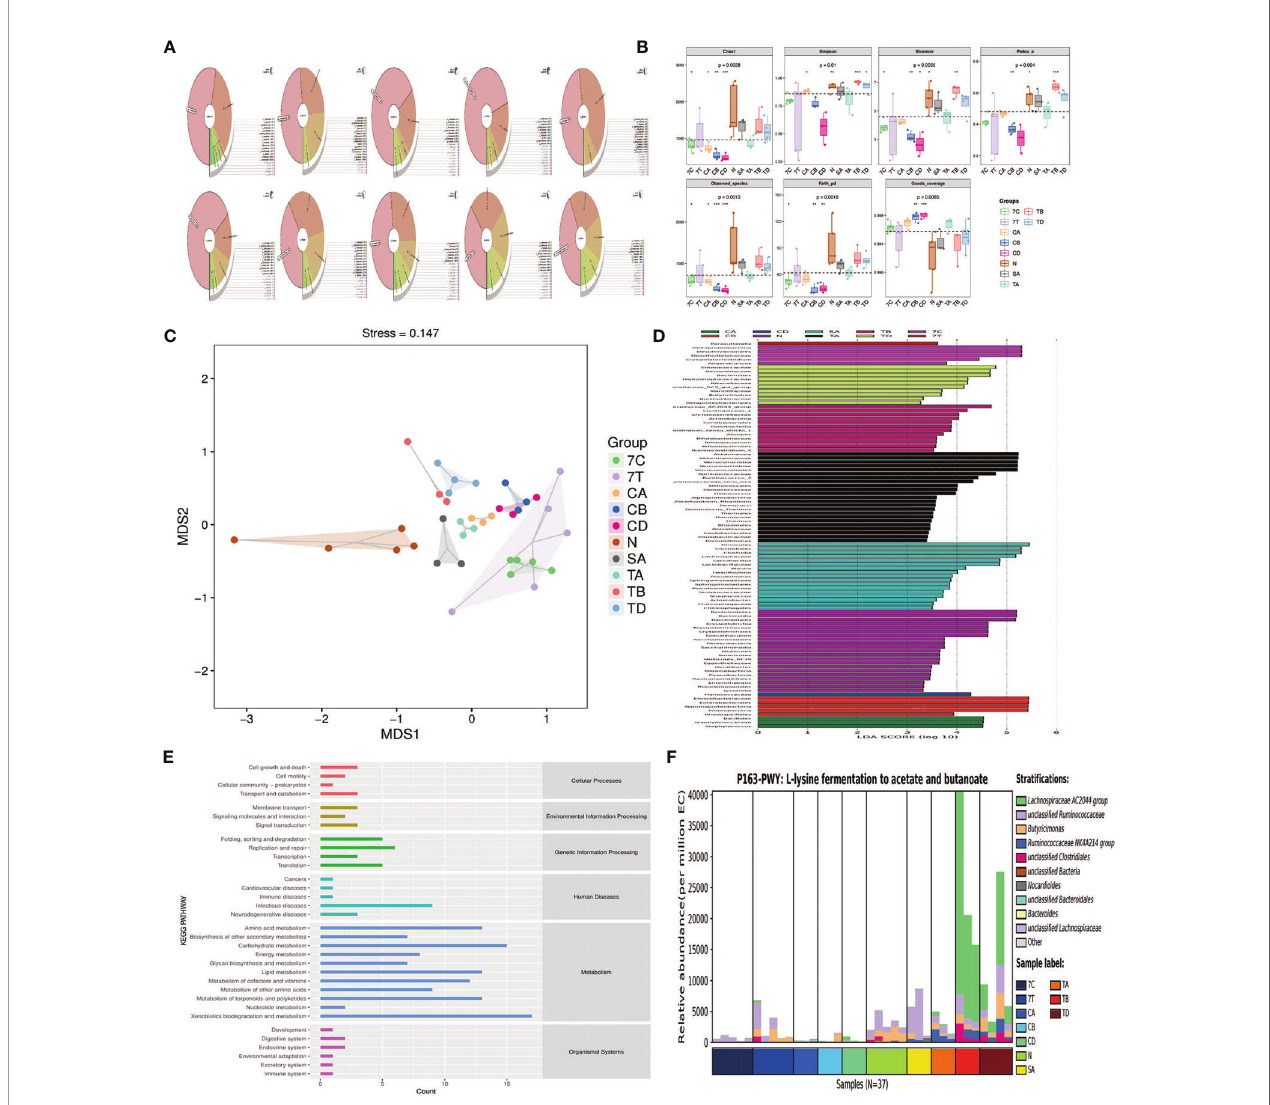
FIGURE 7 | Microbiota analysis. (A) Krona species at phylum among the Normal, Sham, CLP, and FMT groups. (B) Alpha diversity. *P < 0.05, **P < 0.01 ****P < 0.001. (C) NMDS two-dimensional sorting diagram. The closer the distance between the two points in the fi gure, the smaller the difference between the microbial communities in the two samples. (D) LEfSe (LAD Effect Size). A longer bar denotes a more signi fi cant difference in the taxon. The color of the bar graph indicates the most abundant sample group corresponding to the taxon. (E) Predicted abundance map of KEGG secondary functional pathways. (F) Species composition map of differential MetaCys metabolic pathways. The abscissa shows different groups. The order of the samples in the groups was sorted according to the similarity of the data; the ordinate was the relative abundance of the metabolic pathways, and the species different levels of contribution to the metabolic pathways were displayed in different colors at different levels. (In order to show the results better, we used abbreviations to represent each group: N = normal mice, 7C = CLP group mortality observation, 7T = FMT group mortality observation, SA = Sham group 12 h; CA, CB, and CD = CLP group at 12, 24, and 48 h time points, respectively, and TA, TB, and TD = FMT group at 12, 24, and 48 h time points,